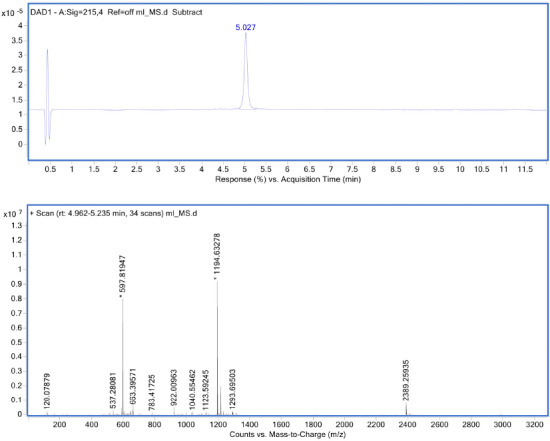
Electrospray ionisation (positive ion) mass spectrum of (34Pro, 35Phe)CGRP27-37 to demonstrate there was no change in peptide structure after formulation and release from chitosan nanoparticles. HPLC-MS analysis of a solution (1 mg/ml) of released peptide.